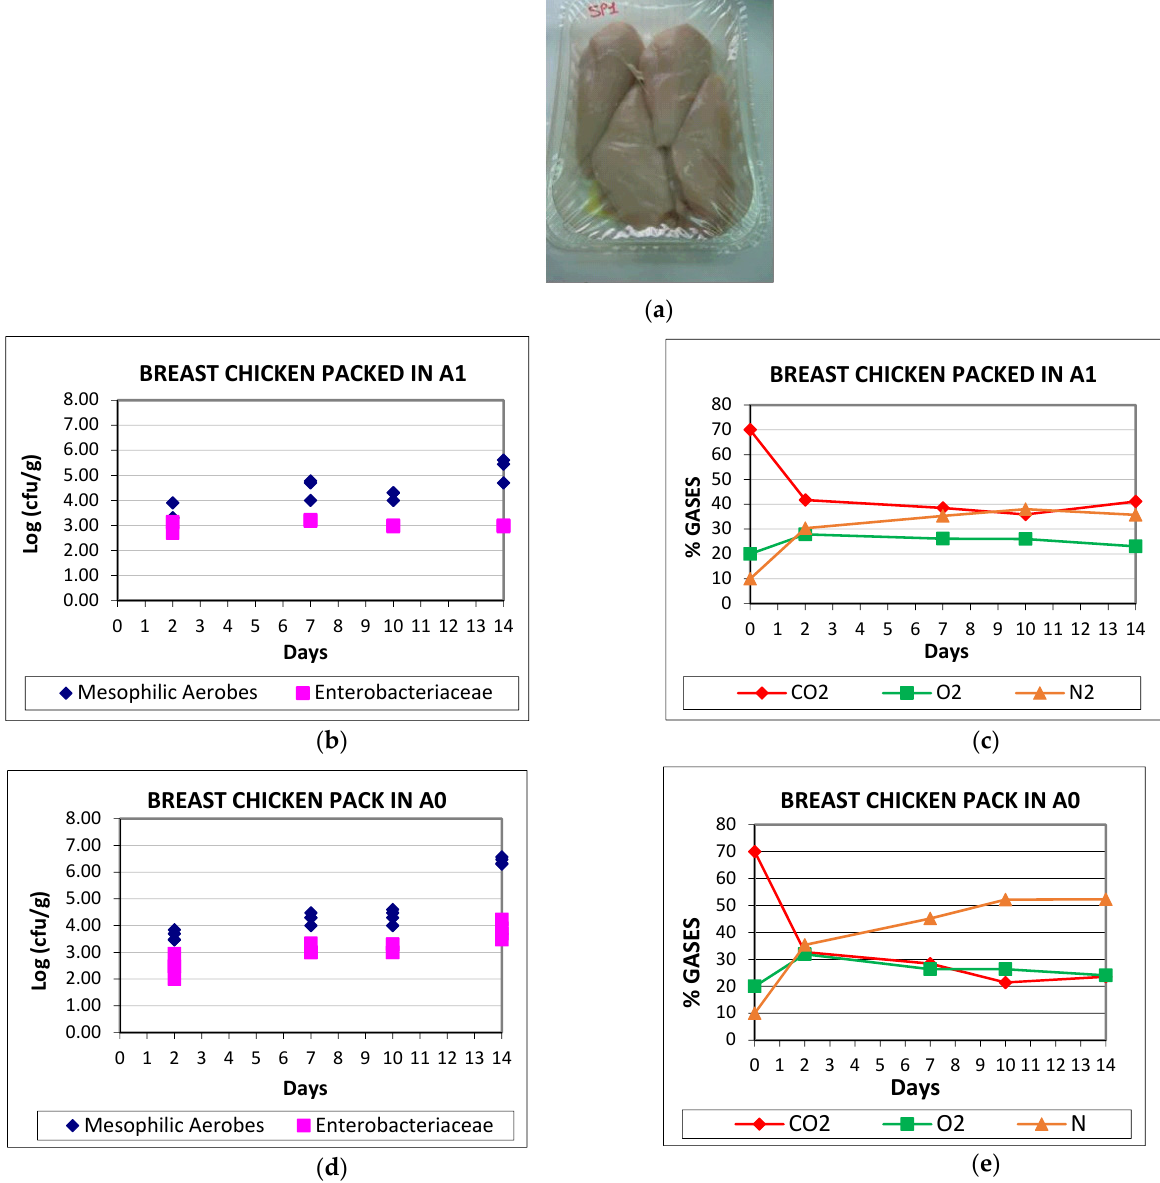
Figure 3. Picture of the packed chicken ( a ), aerobic mesophilic and Enterobacteriaceae count ( b , d ) and gases concentration evolution in 2 kg chicken breast ( c , e ), packed in A1 and A0 nanocomposite tray, respectively. Regarding total count of Enterobacteriaceae (EB), the average value of PET trays ana- lyzed is 3.83 log (cfu/g) (8.25 × 10 3 ufc/g) whilst this number is 2.98 log (cfu/g) (9.67x10 2 ufc/g) for the nanocomposite tray. Thus, nanosepiolite trays have lower microbiological charge. EB remains practically constant and very low from day 2 to 14 for the nanocom- posite trays, starting at an average log (cfu/g) of 2.83 and ending, at 14 days, at 2.98, whereas in PET trays, although the starting count of Enterobacteriaceae is lower, log (cfu/g) 2.43, at day 14 it is of 3.80. The explanation for the lower growth of bacterial counts could be due not only to CO 2 [24] but also to N 2 capability of inhibiting bacterial growth [25,26]. Figure 3b,d shows head space gases evolution for the breast chicken packed in nano- composite’s trays and in PET tray. CO 2 content decrease is mainly due to product absorp- tion into the food [21–28], but also to loss of the gas through permeation across the plastic. Major CO 2 absorption takes place during the first two days in the two samples, resulting in an equilibrium concentration, lower than the initial [29]. The absorption of CO 2 depends